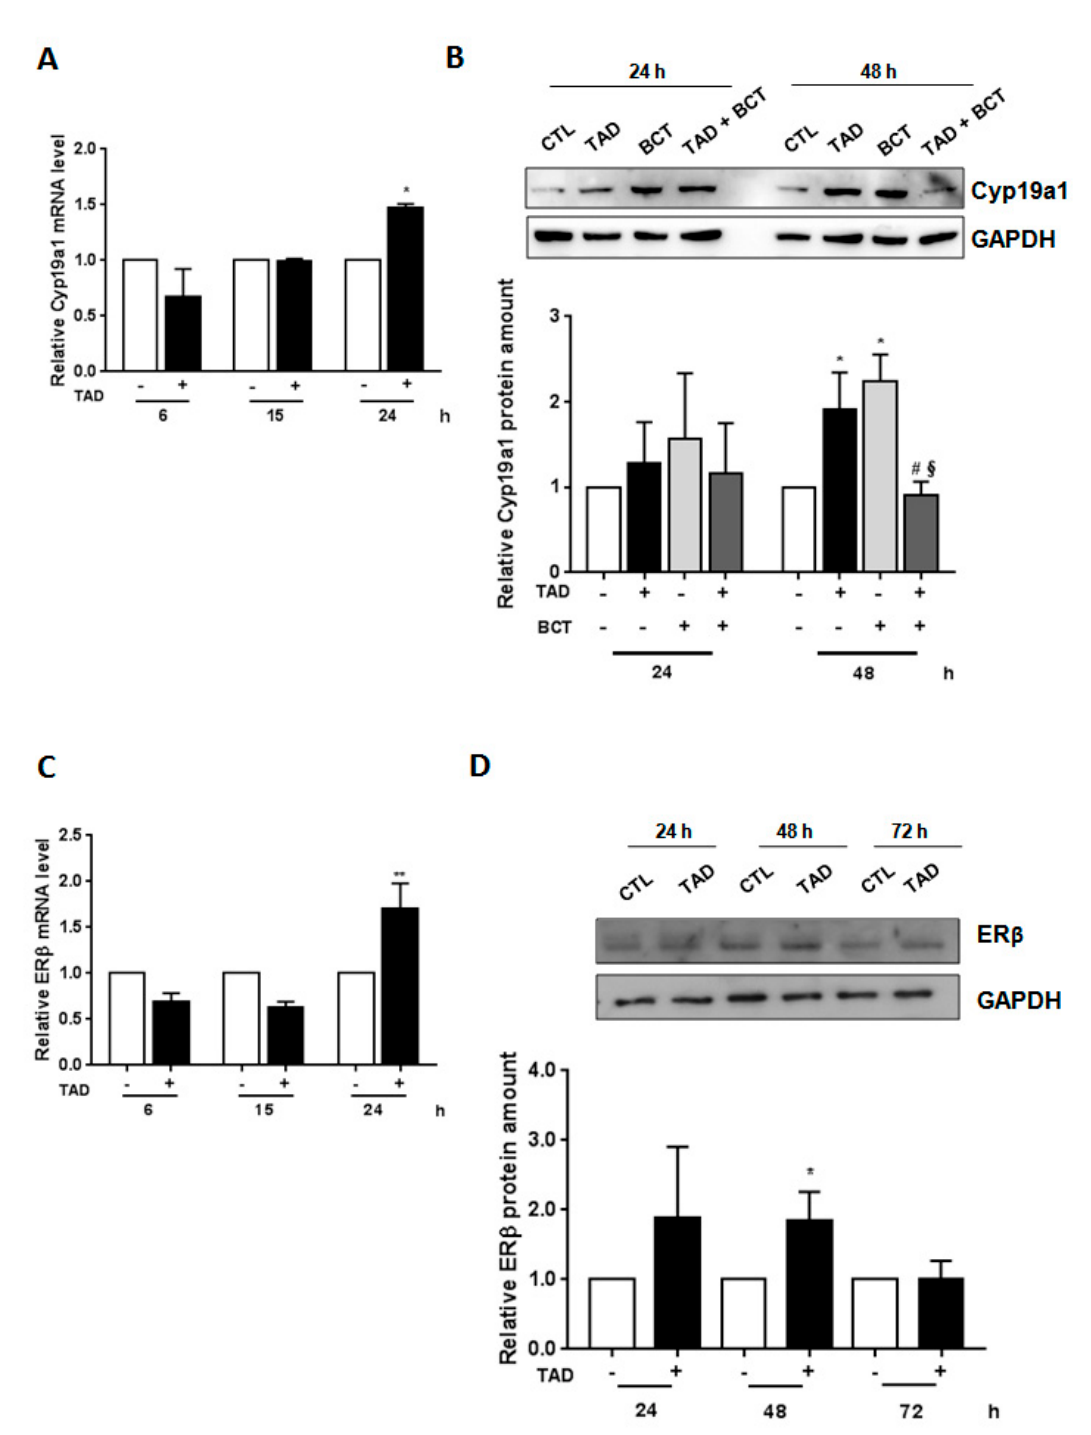
Figure 3. TAD dependent-increase of Cyp19a1 and ER β expression and BCT-mediated Cyp19a1 downregulation. ( A , C ) Effect of TAD on Cyp19a1 and ER β mRNA expression in LNCaP cells, either exposed or not to TAD (10 − 6 M) for 6, 15 and 24 h. ( B ) A representative Western blot of Cyp19a1 protein is shown in LNCaP cells cultured in the presence (+) or in the absence ( − ) of TAD (10 − 6 M) and/or BCT (10 − 4 M) for 24 and 48 h. ( D ) A representative Western blot of ER β protein is shown in LNCaP cells cultured in the presence (+) or in the absence ( − ) of TAD (10 − 6 M) for 24, 48 and 72 h. GAPDH, control of protein loading. Results are shown as mean ± SE ( n = 3) of three separate experiments. * p < 0.05, ** p < 0.005 vs. CTL cells, # p < 0.05 vs. TAD treated cells, § p < 0.05 vs. BCT treated cells.